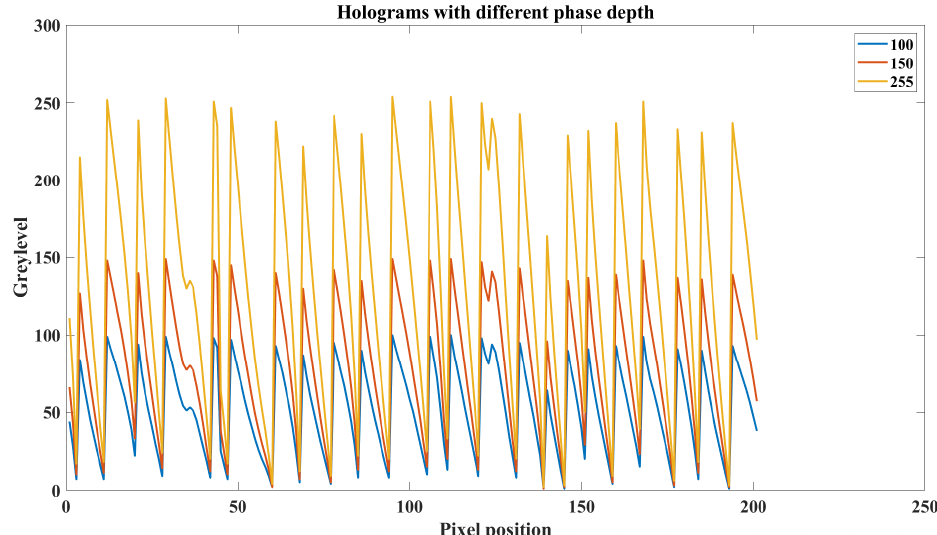
Figure 4. The partial phase profile of one hologram under three different phase depths.